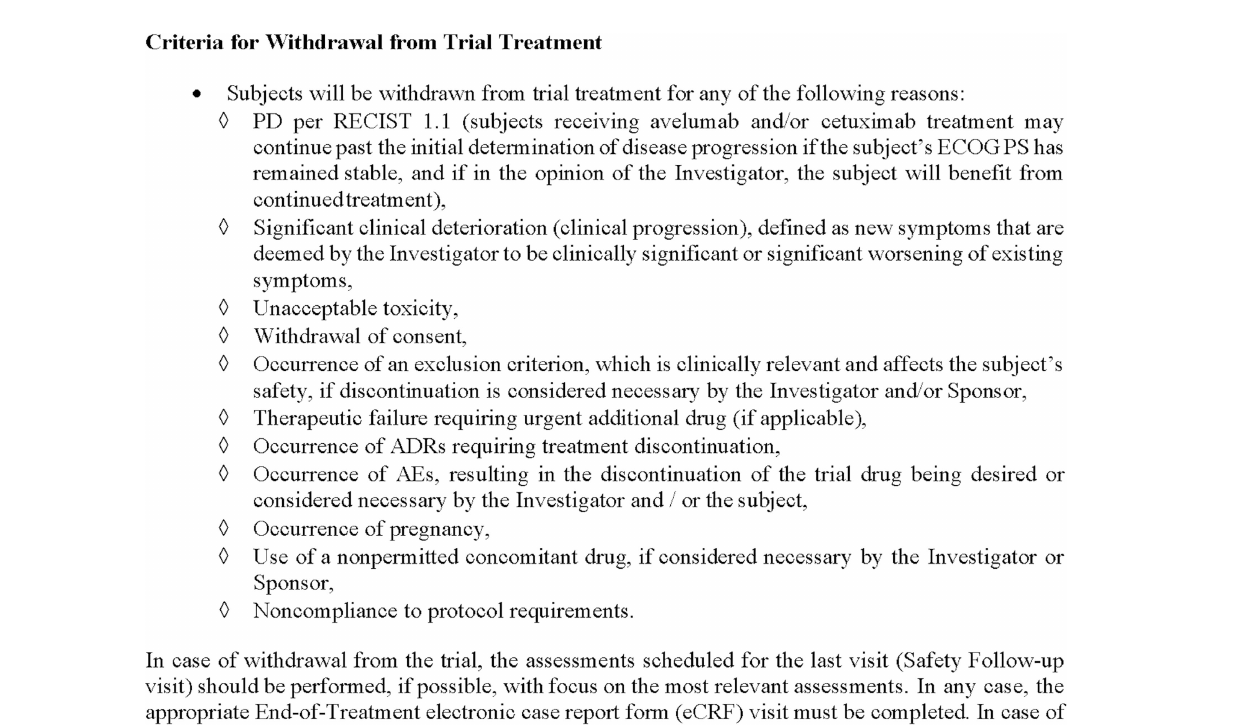
FIGURE 2 | Criteria for withdrawal from trial